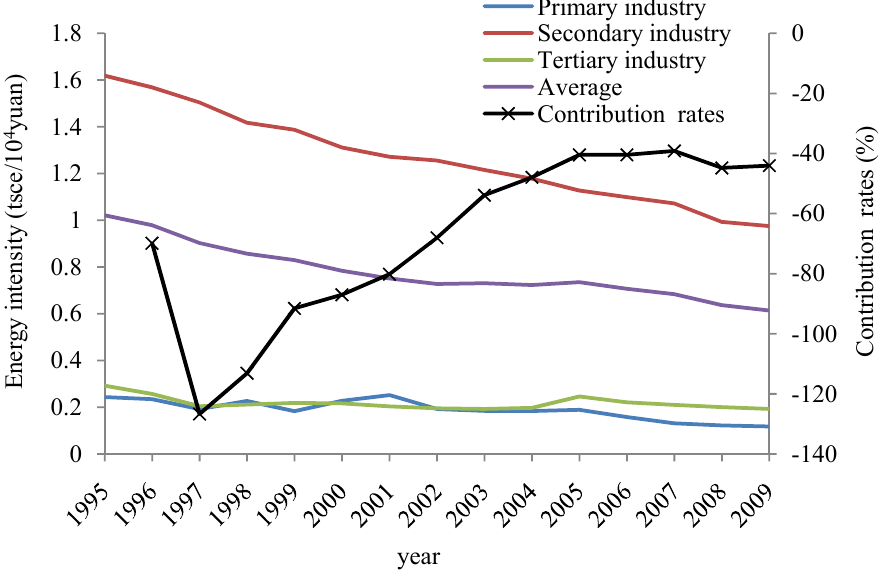
Figure 9. Changes of energy intensity and contribution rates of energy intensity